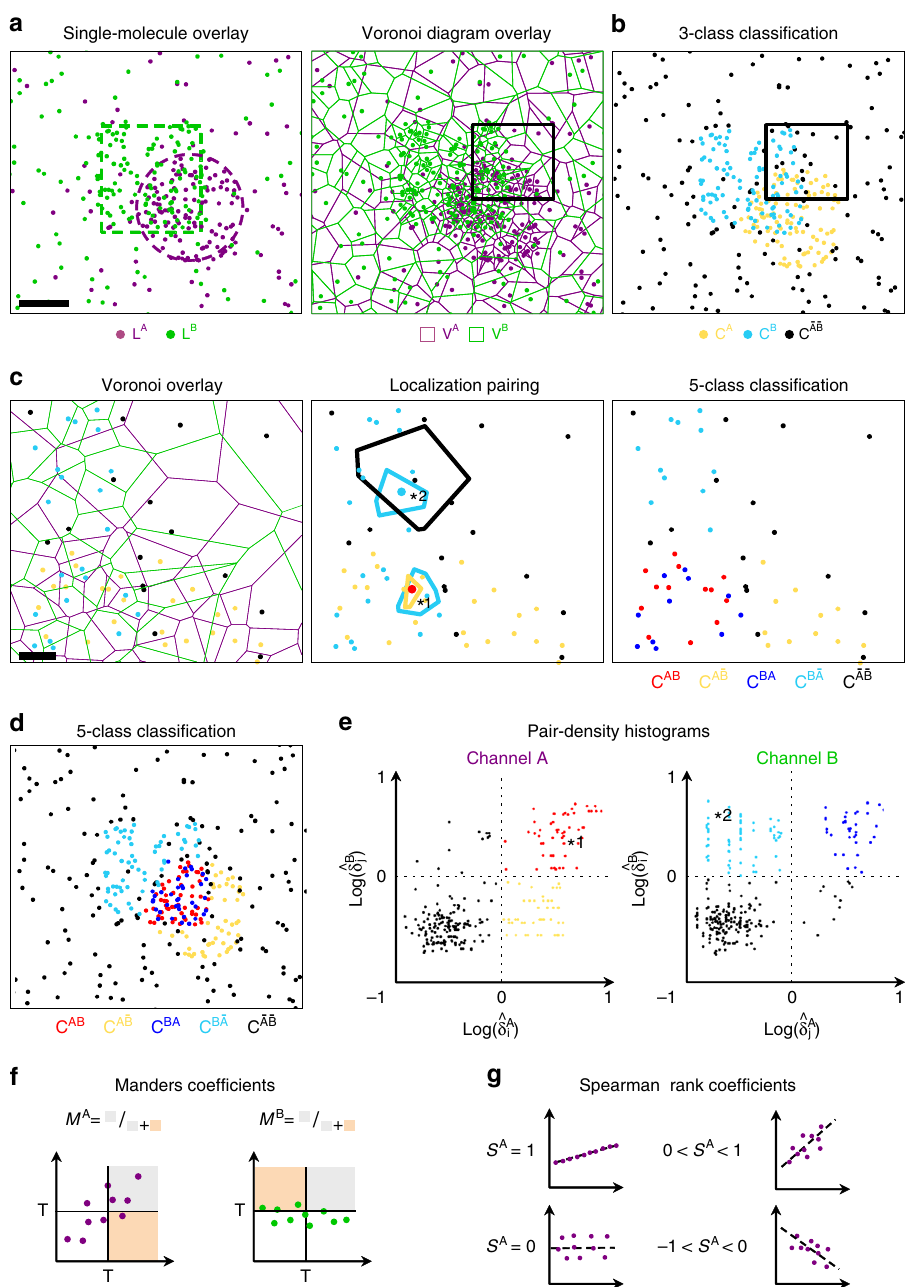
Fig. 1 Voronoï-based colocalization analysis. a Simulated 2-colors SMLM dataset composed of 100 nm partially overlapping clusters with circular and square shapes (left) (scale bar 50 nm). Overlay of the Voronoï diagrams generated from the 2-colors localizations (right). b Automatic density-based classi fi cation of the localizations in 3 classes segmented with b δ i > 1. Localizations are colored on a per-class basis: the yellow (resp. cyan) class C A (resp. C B ) represents localizations with high densities in the channel A (resp. B) and the black class C (cid:1) A (cid:1) B regroups the localizations with low densities in both channels. c Classi fi cation of the localization in 5 classes. Magni fi ed region of ( a , b ) showing localizations classi fi ed in C A , C B or C (cid:1) A (cid:1) B , together with the two overlapping Voronoï diagrams (left) (scale bar 10 nm). Each localization is described by a pair of normalized densities, extracted from the overlapping polygons in which it relies (middle). For simpli fi cation, only the Voronoï cells of 2 localization pairs (described by the star numbered 1 and 2) have been displayed. Two additional classes C AB and C BA (red and blue), sub-divide the high-density classes C A and C B from localizations having high densities in both channels (right). d Final 5 classes density-based classi fi cation of the 2-color localizations. e Scatterplot representation of normalized densities pairs in log-scale axes for the 2 channels. Scatterplots are de fi ned for each channel, always keeping the density of channel A in abscises and the density of channel B in ordinates. The 5 classes are highlighted by the division of the scatterplots at (0,0) coordinates. f , g Principle of the Manders ’ coef fi cients ( f ) and Spearman rank correlation ( g ) for quantitative colocalization